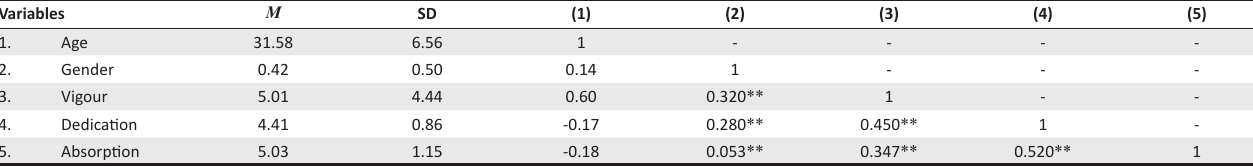
TABLE 1: Means, standard deviations and inter-correlations among variables ( N = 225).